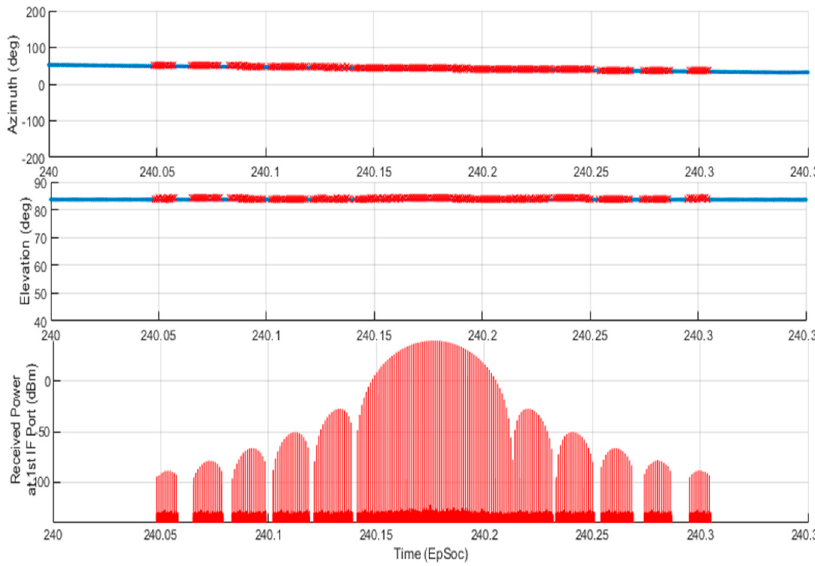
The bottom plot of Figure 13 also shows the received signal power level from the first IF output port that is node-3 in the cyan box of Figure 11. Each line in the plot tells the TAR antenna scans over the aircraft in the scenario, and the RESM receiver has the oppor- Figure 14. The estimation errors in Az and El. tunity to conduct AoA measurement. Figure 15 displays the data in between 240 to 240.35 (EpSec), which is the last line of TS1 in the bottom plot of Figure 13.